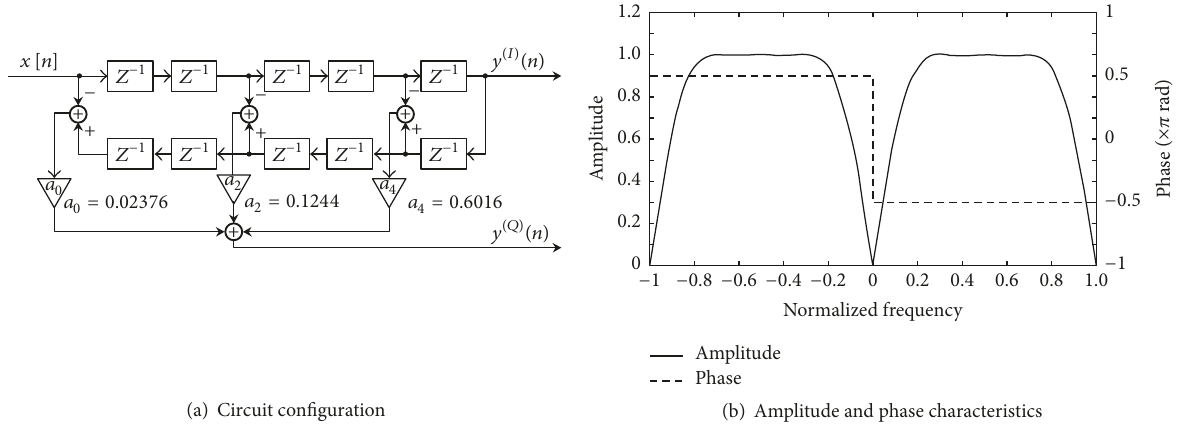
Figure 9: Hilbert transformation circuit for realizing a relative bandwidth equal to 1.